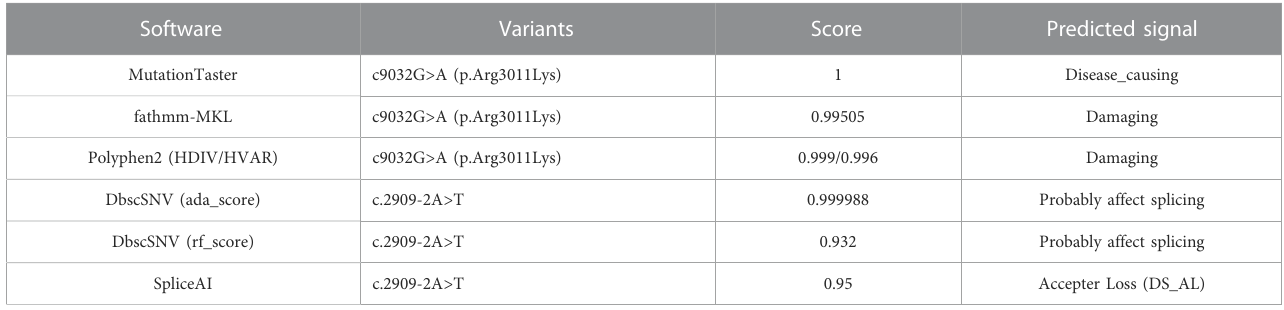
TABLE 1 The effects of LRP2 variations on their protein function by in silico